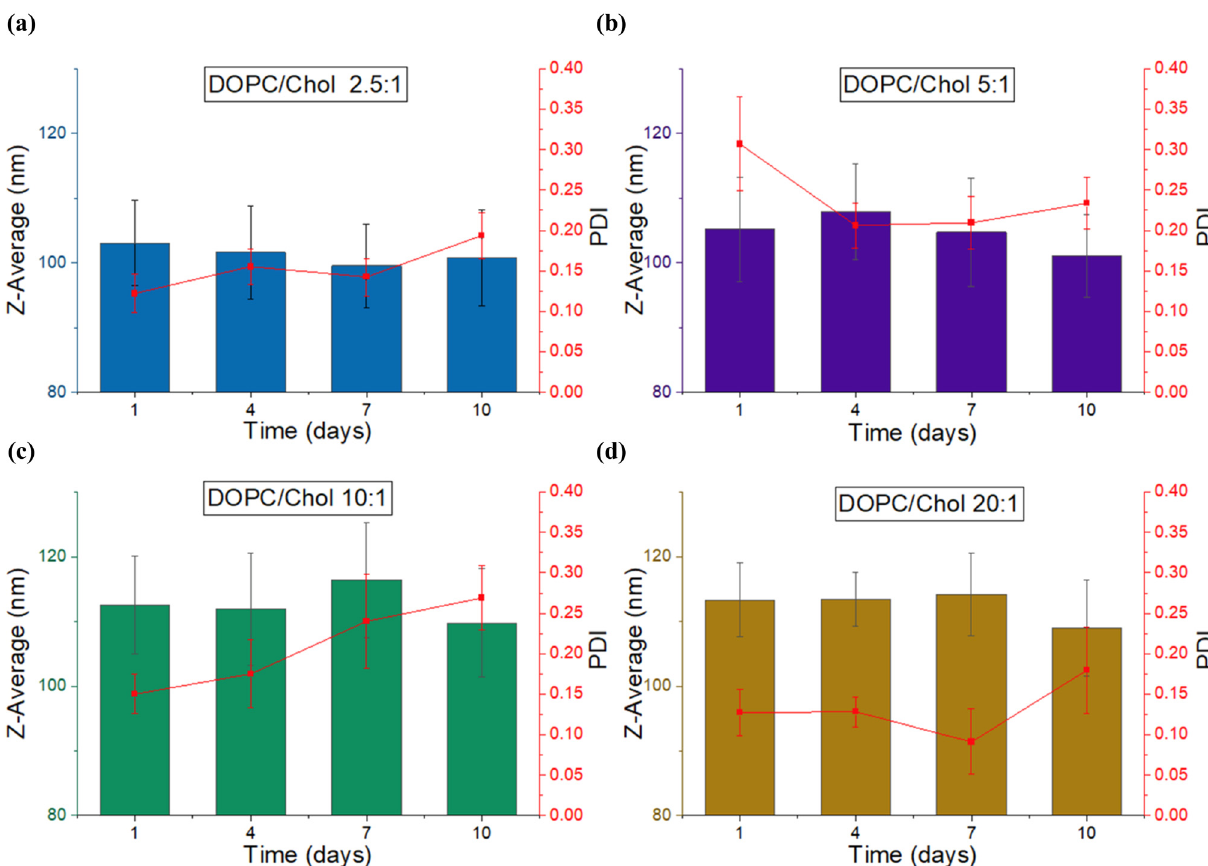
Figure 1: Size distribution of DOPC liposomes with di ff erent lipid/Chol ratios. ( a ) DOPC/Chol ratio 2.5:1 ( mol/mol ) , ( b ) DOPC/Chol ratio 5:1 ( mol/mol ) , ( c ) DOPC/Chol ratio 10:1 ( mol/mol ) , and ( d ) DOPC/Chol ratio 20:1 ( mol/mol )